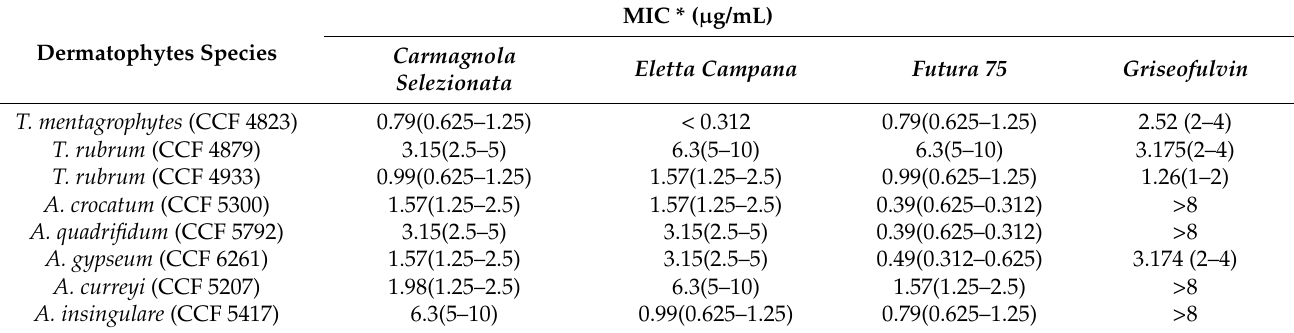
Table 4. Minimum inhibitory concentration (MIC) of industrial hemp essential oils toward selected dermatophyte strains.